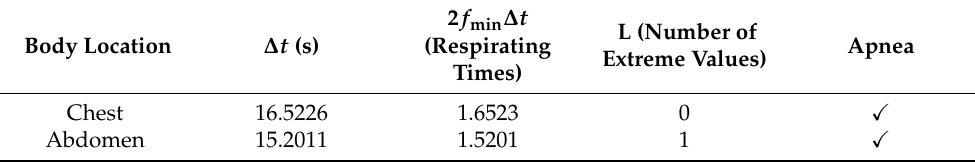
Table 5. Apnea monitoring results without Butterworth bandpass filtering.